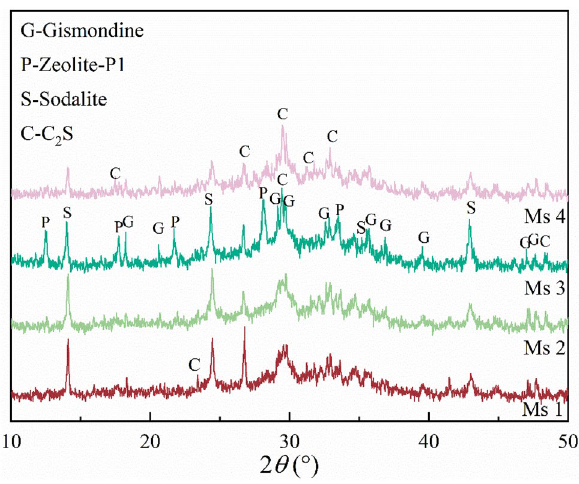
Figure 4. XRD patterns of hydrothermal products with different sodium silicate modulus (Ms) value; Ms 1: sodium silicate modulus is 1.0, Ms 2: sodium silicate modulus is 2.0, Ms 3: sodium silicate modulus is 3.0, Ms 4: sodium silicate modulus is 4.0.